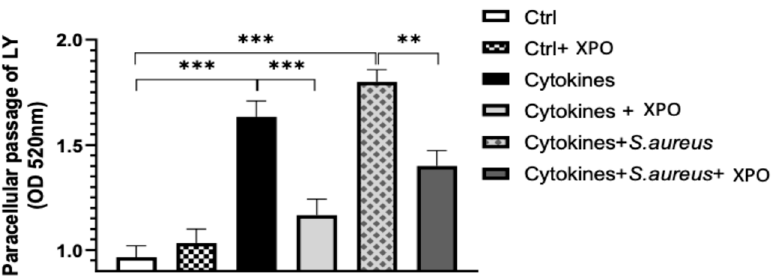
Figure 2. LY permeation test. LY assay showed that stimulation with cytokines mix or with cytokines mix + S. aureus after 24 h significantly increased the paracellular flux of LY compared to unstimulated HaCaT cells, while XPO reduced LY permeation, indicating reduced epithelial permeability. Values are indicated as the mean ± SEM. *** p < 0.001 and ** p < 0.01.